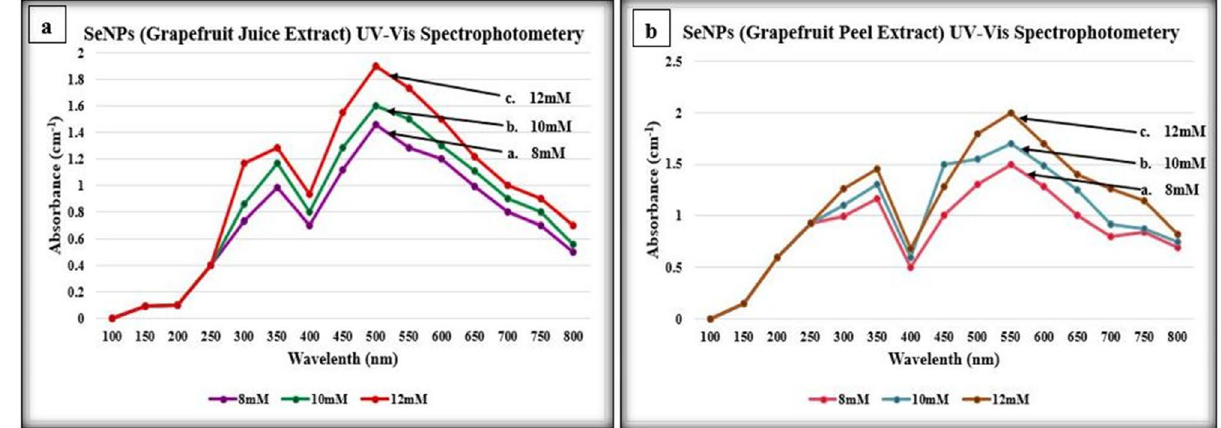
Figure 2. UV–Vis spectrophotometry analysis of SeNPs synthesized from Citrus paradisi (Grapefruit); ( a ) fresh juice extract, ( b ) fresh peels extract.